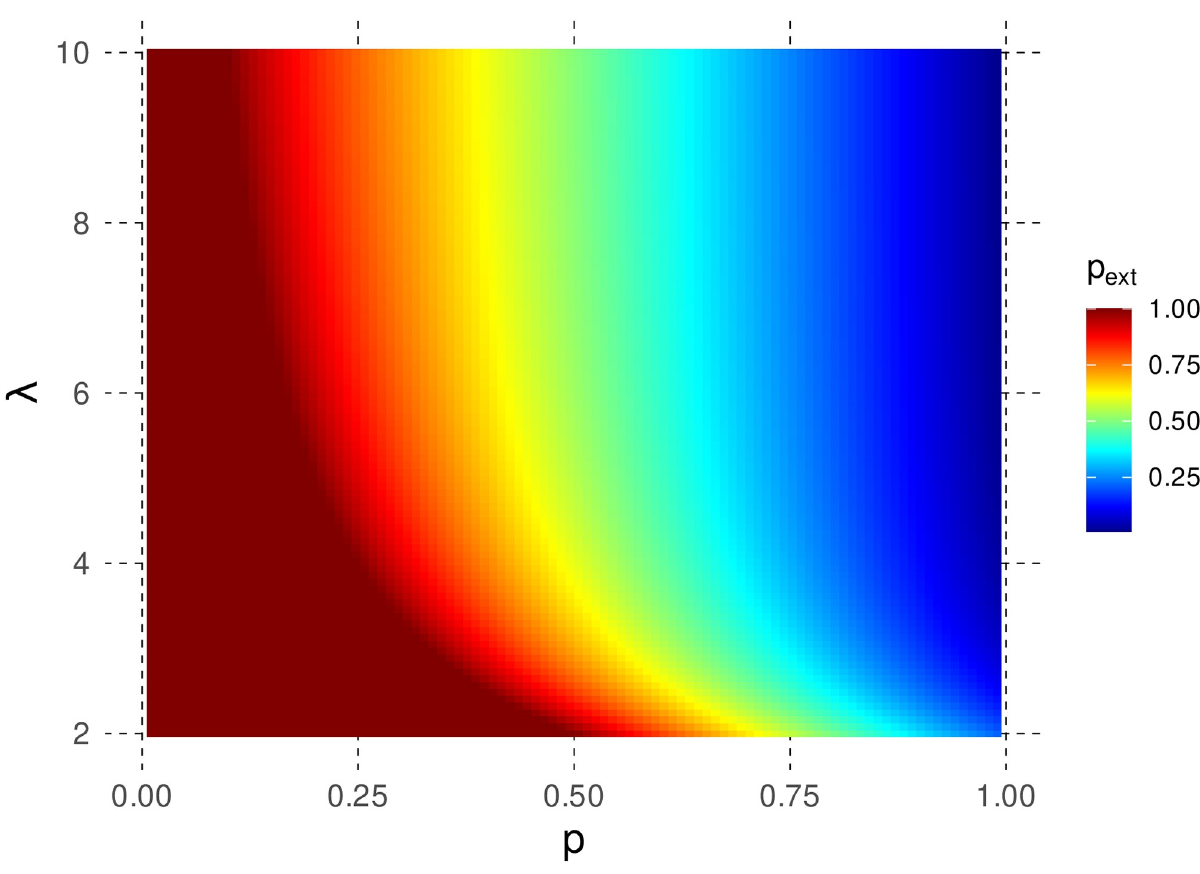
Fig 2. Effect of episome replication ( λ ) and asymmetry in episome partitioning ( p ) on the cumulative probability of extinction ( p ext ). We here assume a Poisson scenario. p ext decreases with both λ and p , and reaches a threshold p ext = 1 − p for a given p when λ increases. This is consistent with the fact that if λ is sufficiently high, the main source of extinction is the first cell division of a stem cell containing 1 episome.